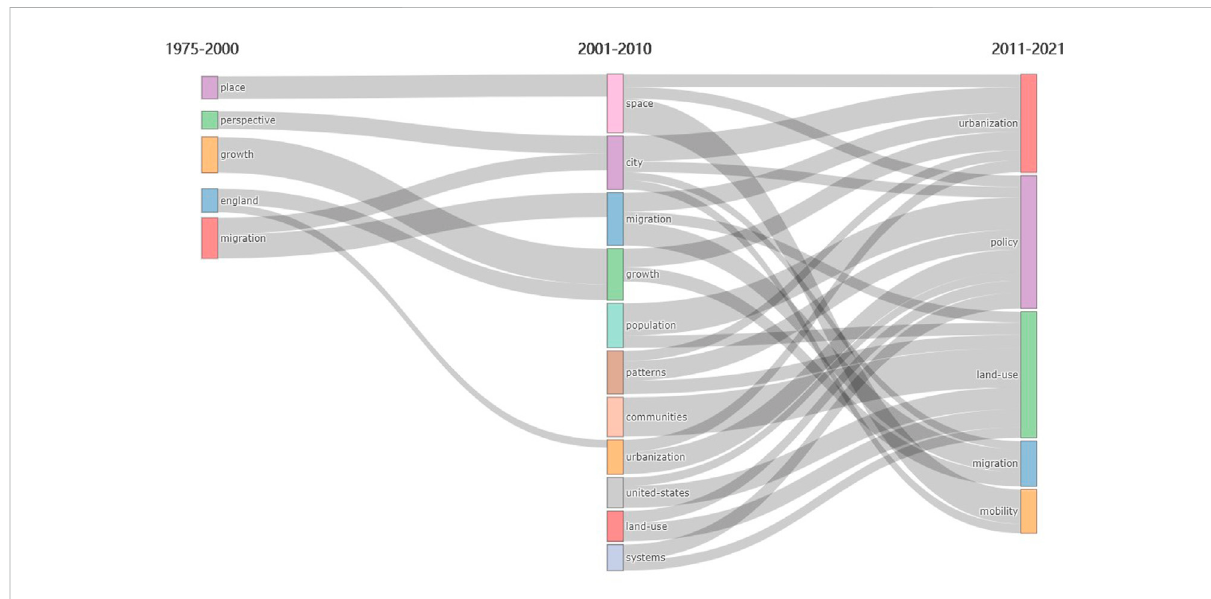
Theme Evolution of the Field of Rural Settlements from 1973 to